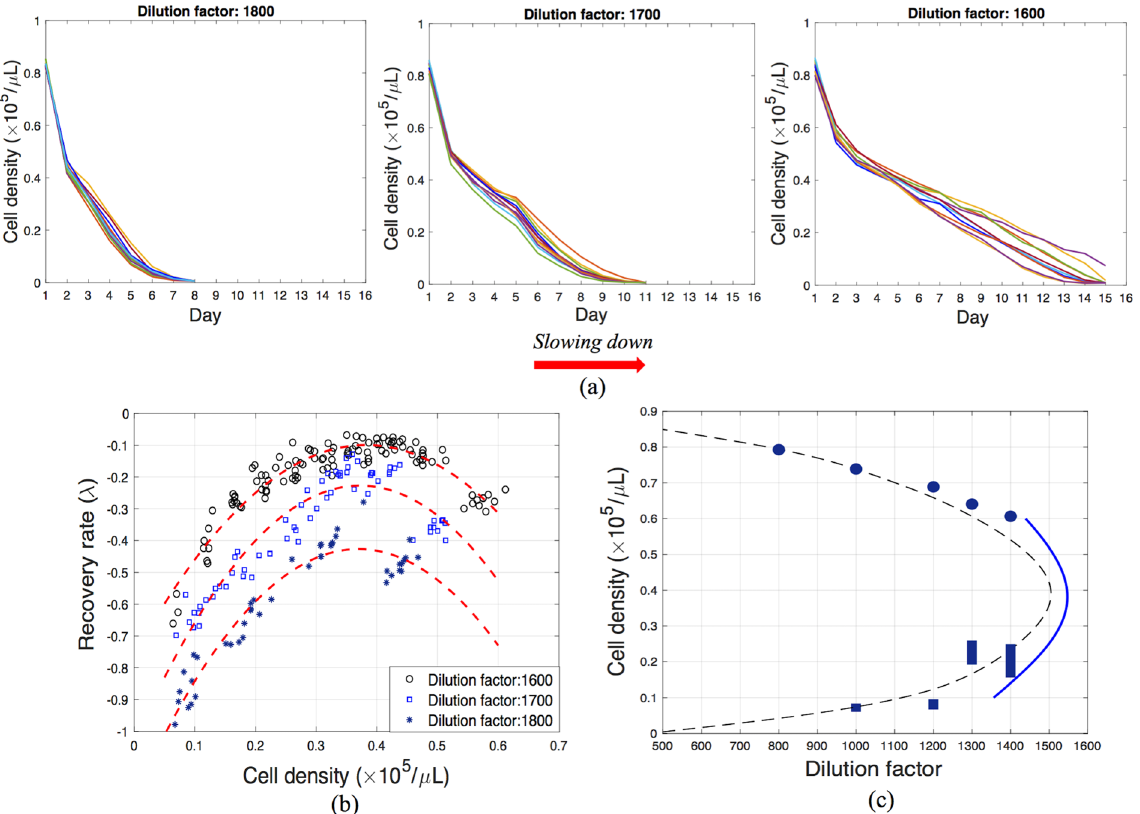
Figure 6. Forecasting using measurements at dilution factors of 1,600, 1,700 and 1,800 corresponding to case ( b ) shown in Fig. 2. ( a ) Measured recovery of the yeast population from perturbations at three selected dilution factors for the system approaching the tipping point from parameter values greater than the critical parameter. Each line represents a separate experiment, and each experiment has 7 replications which are performed simultaneously using the same source of materials at exactly the same experimental conditions. ( b ) Recovery rates at each amplitude computed from measurements shown in ( a ) and quadratic polynomial fits. ( c ) Forecasted bifurcation diagram (solid blue line). Circles and vertical solid bars represent experimentally approximated stable and unstable points on the bifurcation diagram. The dashed line is the approximated bifurcation diagram using the calibrated